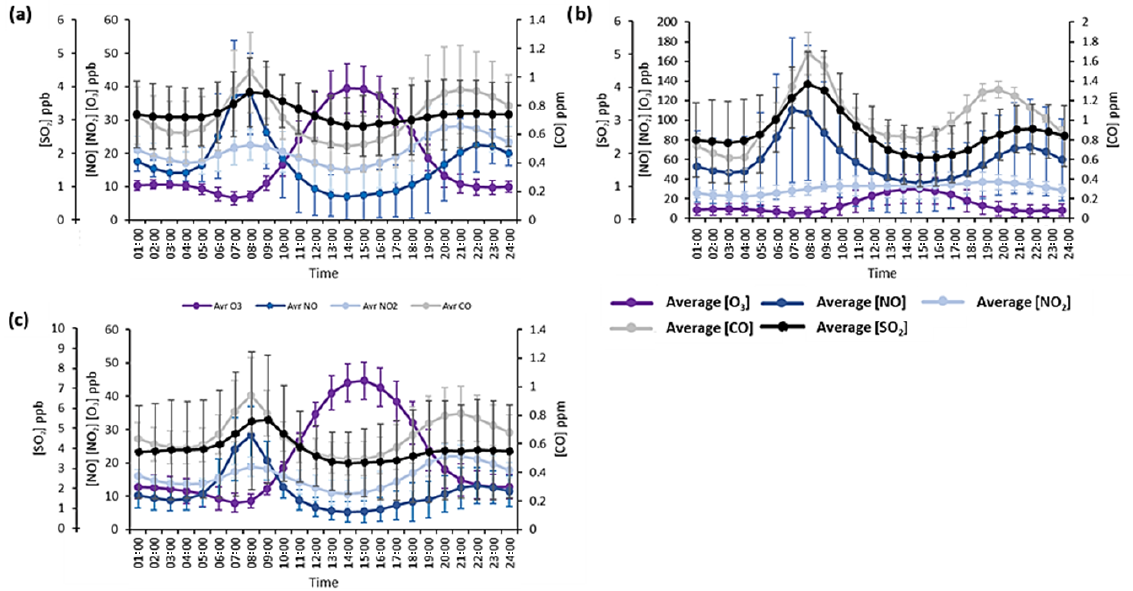
Figure 3. Diurnal variations in gaseous species. The plots provide the average concentrations of O 3 , NO and NO 2 inppb, the average concentrations of CO inppm, and the average concentrations of SO 2 in ppb at (a) BKK sites, (b) roadside sites and (c) BKK suburb sites. Vertical bars provide ± 1 standard deviation of the species